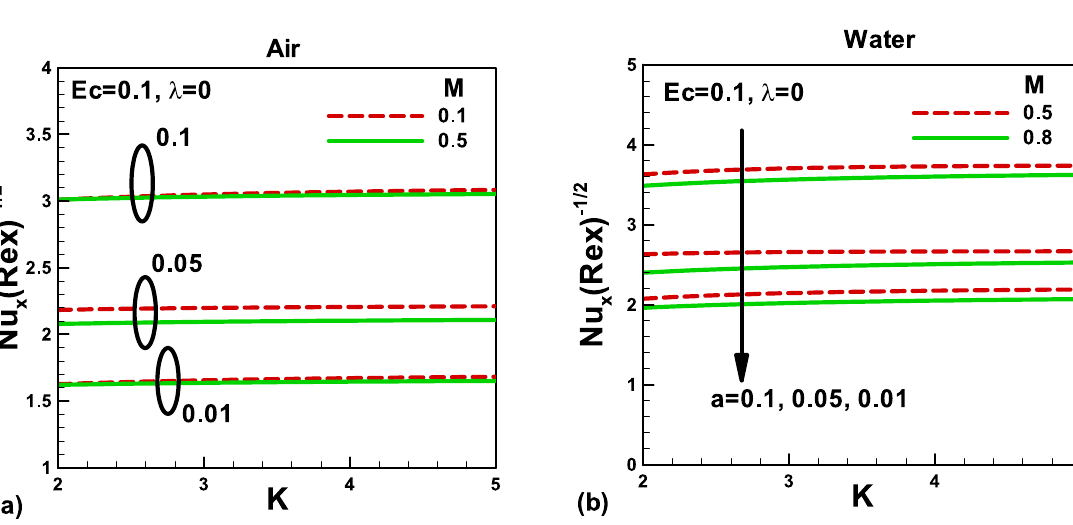
Figure 8. Effects of magnetic and porosity parameters on Nusselt number for (a) air and (b) water, when the needle is fixed in a moving